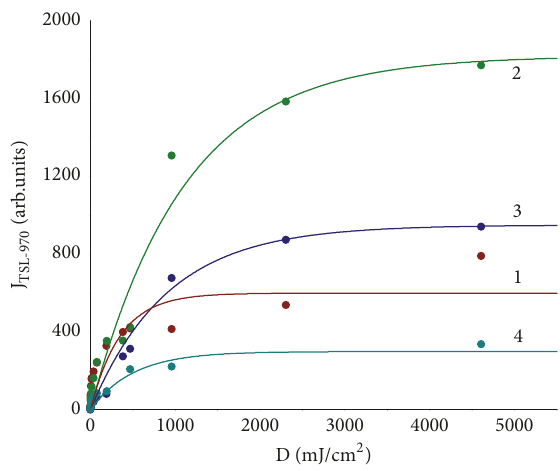
Figure 7: Dose dependencies of the TSL-970 peaks at 𝑇 m = 129 K (1) , 184 K (2) , and 211 K (3) of the sample #1 under two intensities of X-ray excitation (dots) and the theoretical curves of the light sum accumulation (solid lines) by (10) .